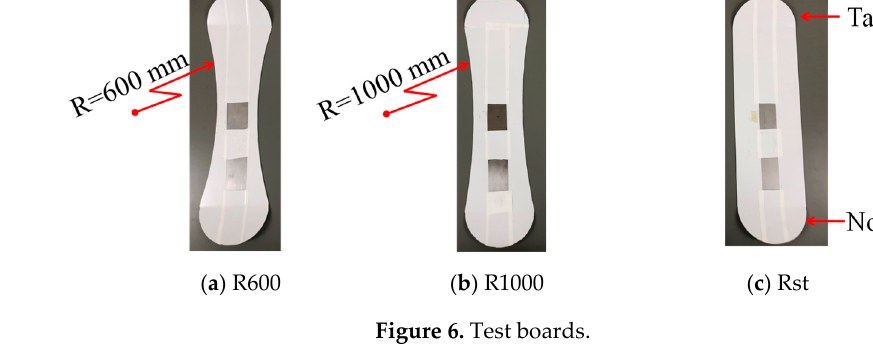
Figure 6. Test boards.